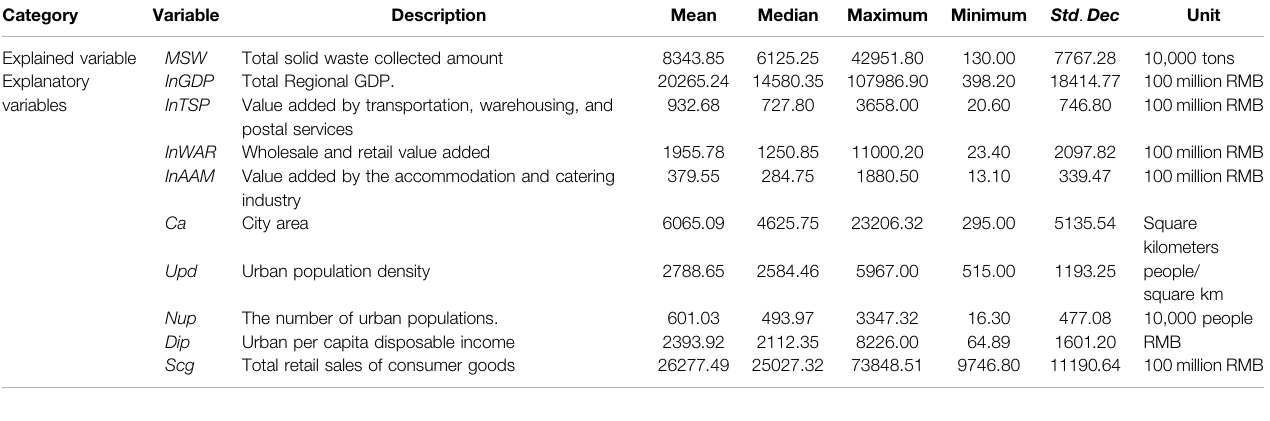
TABLE 1 | De fi nition of variables and descriptive statistics.